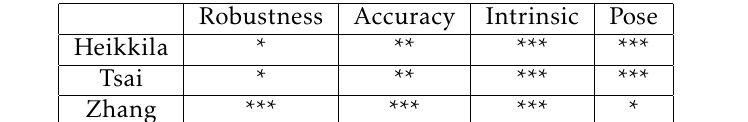
Table 1. Comparison of Heikkila, Tsai and Zhang methods in terms of robustness, accuracy and how easy the intrinsic and pose